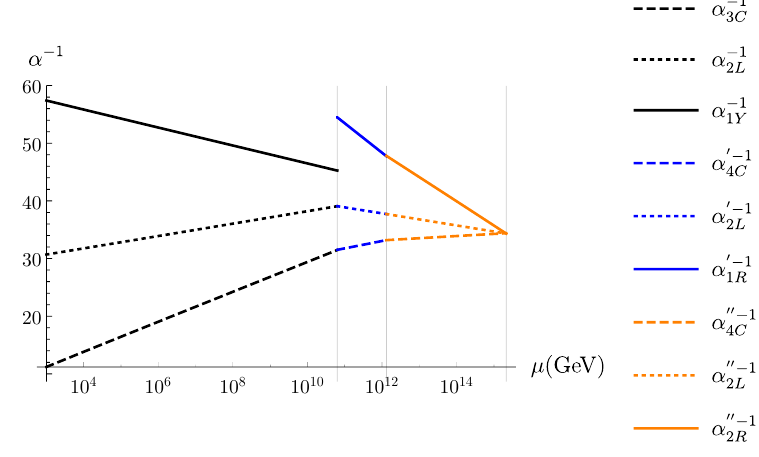
Figure 6 . Running gauge couplings for M BL = 6 : 3 (cid:2) 10 10 GeV in Model 2.1. The corresponding higher uni(cid:12)cations scales are M PQ = 1 : 3 (cid:2) 10 12 GeV and M U = 2 : 1 (cid:2) 10 15 GeV. Threshold correc- tions due to non-degenerate scalars are not included. Beta functions for this model are given